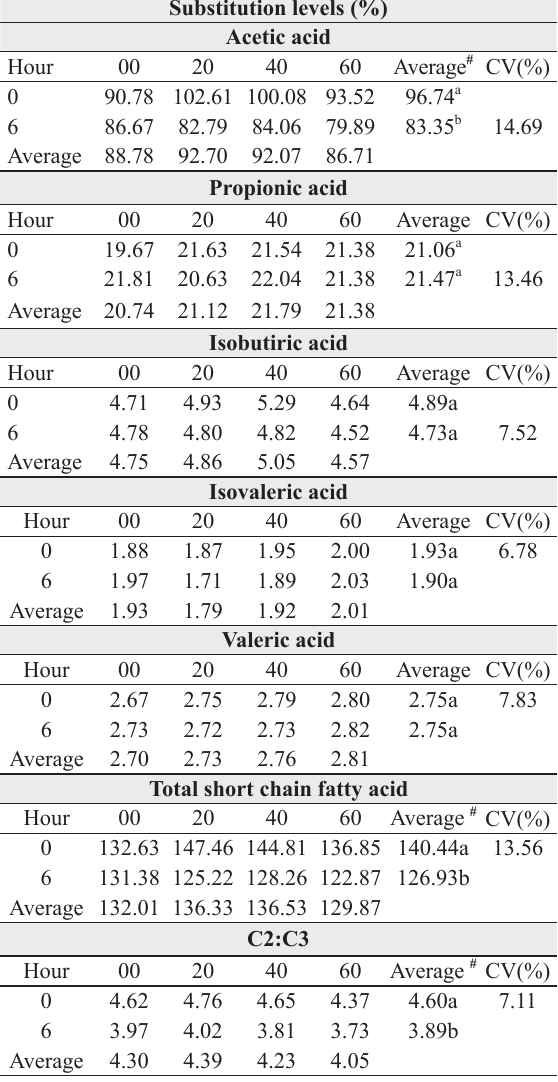
Concentration of short chain fatty acids (mmol/mL), and the acetate:propionate (C2: C3) ratio, of steers supplemented with sunflower crushed in a partial replacement for soybean